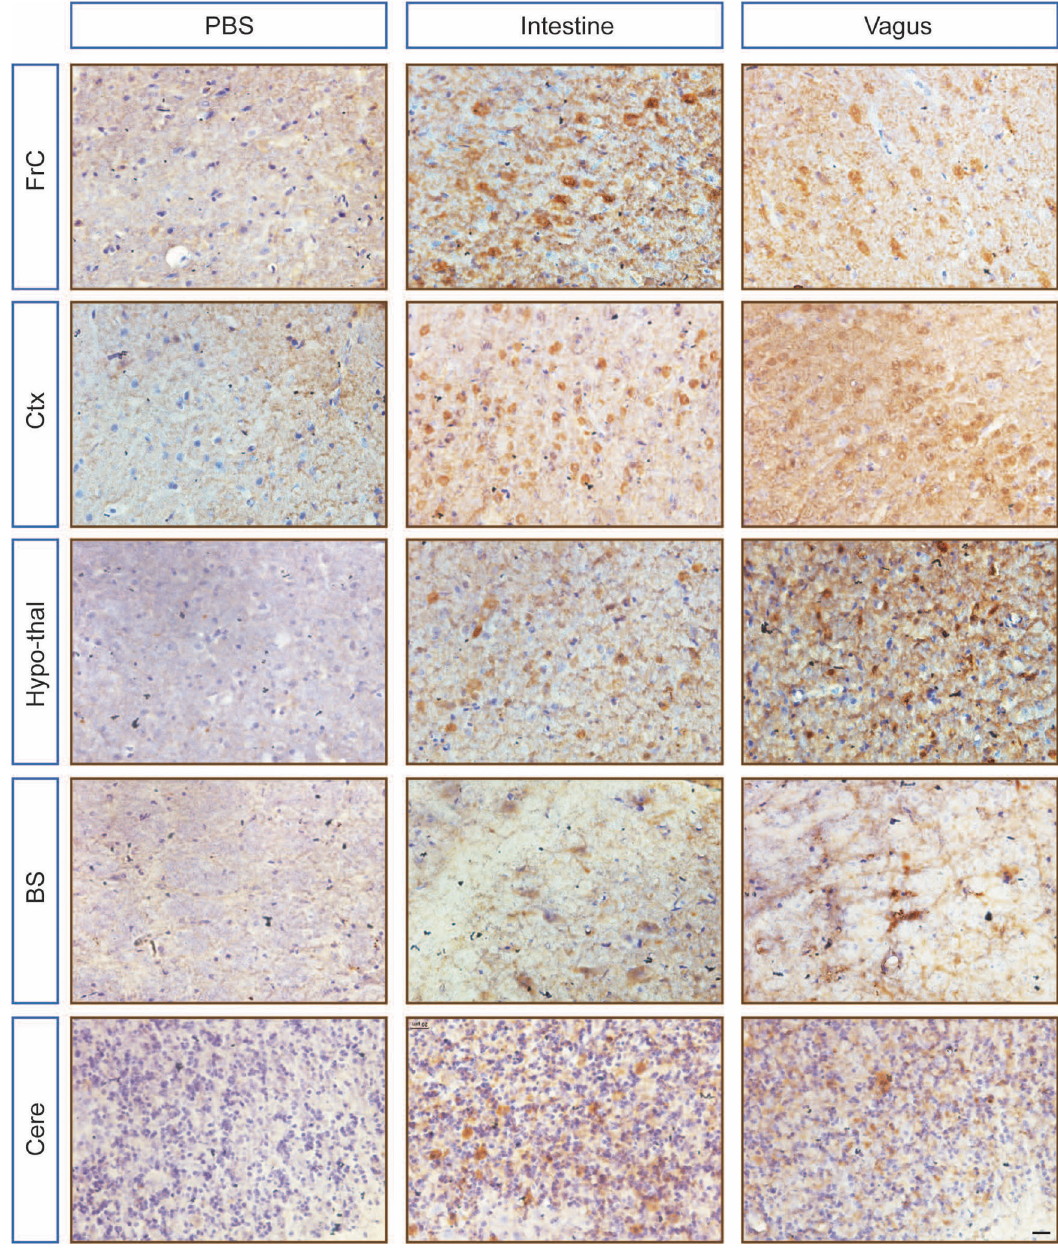
Fig. 5 Cell-cell transmission of α -syn aggregation in bilateral brain regions. Representative images showing α -syn inclusions in the ipsilateral FrC, Ctx, Hypo-thal, BS, and Cere of rats following intrastriatal injection of intestine or vagus nerve lysate derived from a post- mortem PD patient. No obvious α -syn pathology was observed in the rats injected with PBS. Scale bars, 20 μ m. BS brain stem, Cere cerebellum, Ctx somatosensory cortex, FrC frontal cortex, Hypo-thal